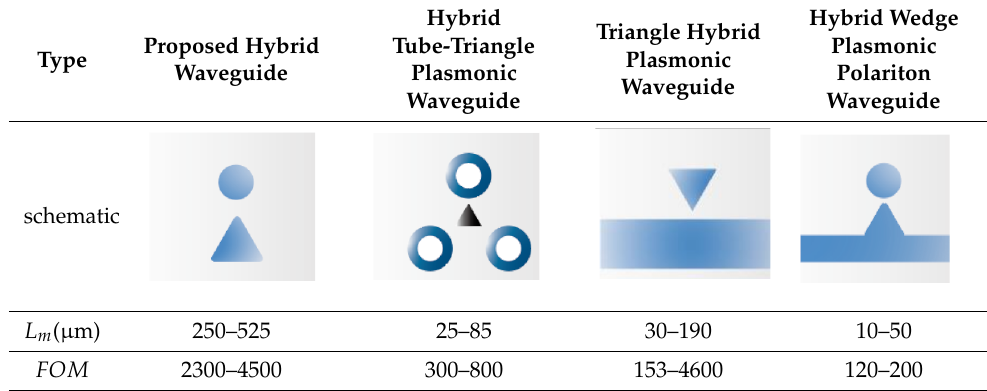
Table 1. Comparisons between the presented hybrid plasmonic waveguide and other waveguides with different